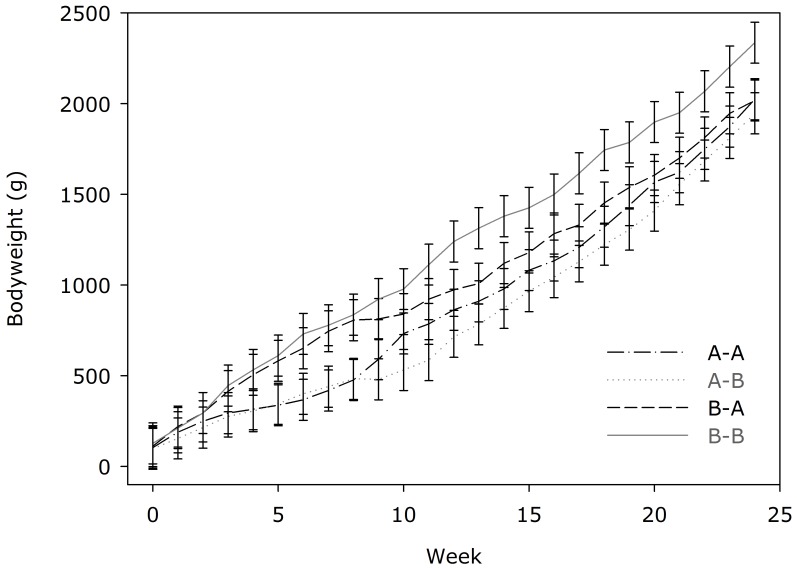
The effects of Diet A or Diet B on growth rates of kittens.Data are reported as means ± SEM.